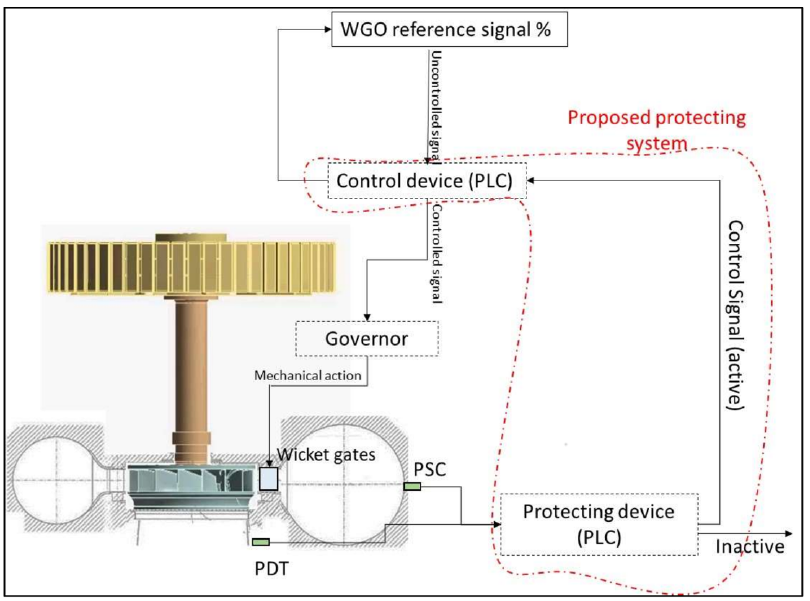
Figure 18. Scheme for the full load instability protecting